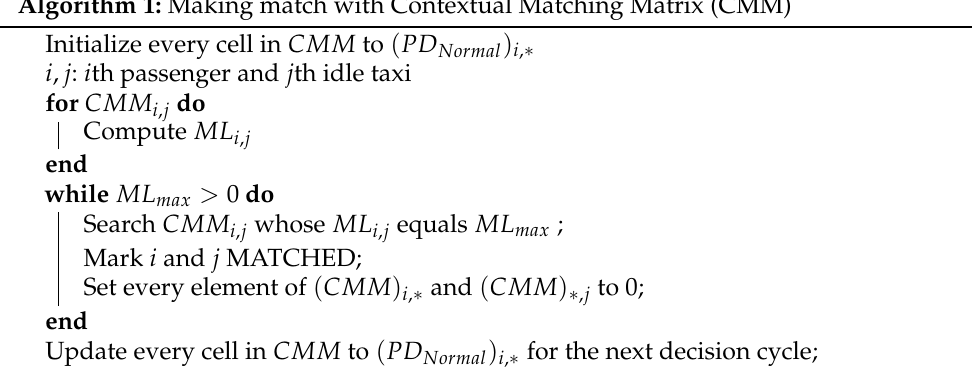
Figure 5. Illustration of CMM after a single taxi-order pair is matched. Algorithm 1: Making match with Contextual Matching Matrix